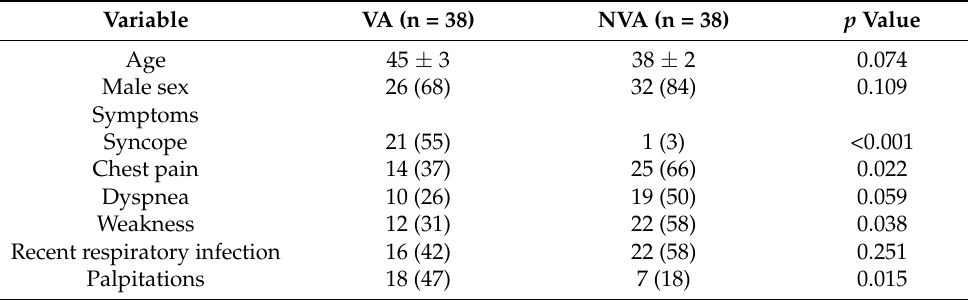
Table 1. Patient baseline